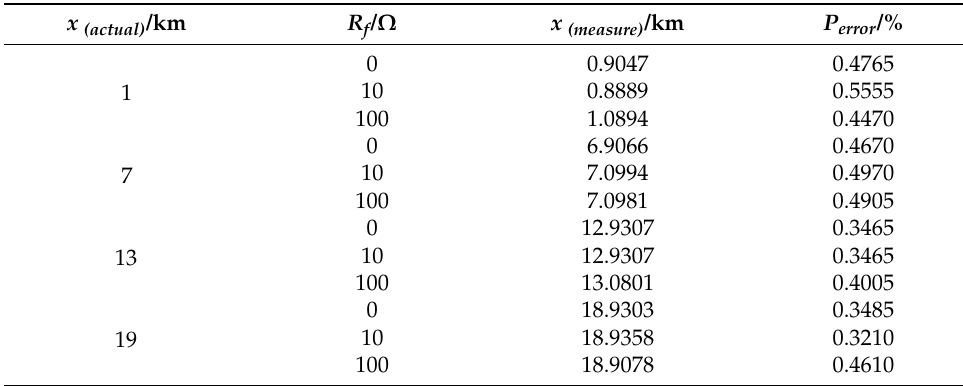
Figure 10. Simulation results for proposed fault location method. Table 3. Location results of proposed fault location